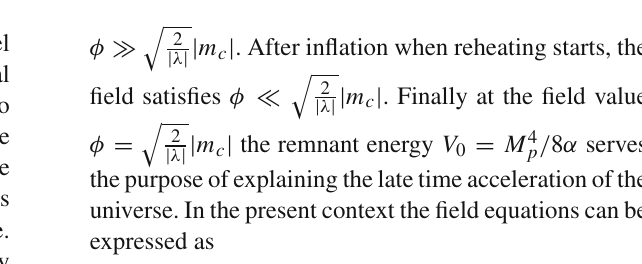
Fig. 3 Behavior of the modified effective potential for case II with a Choice I(v1): V 0 (cid:11)= 0, λ < 0, b Choice I(v2): V 0 (cid:11)= 0, λ > 0, where M p = 2 . 43 × 10 18